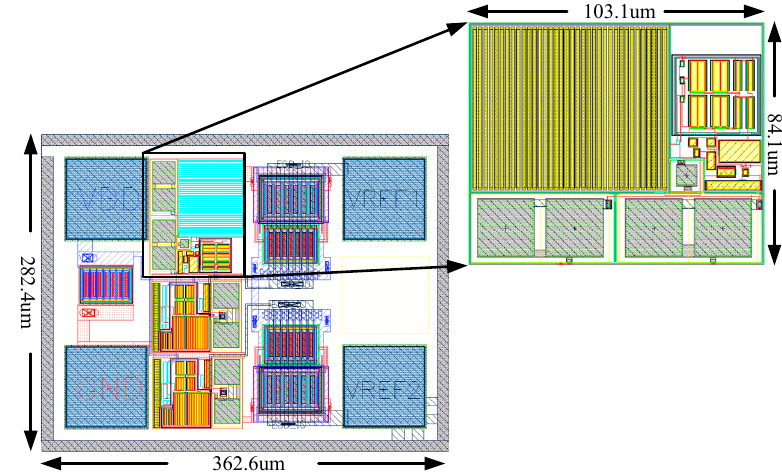
Figure 2. Layout of the dual-output voltage reference circuit.